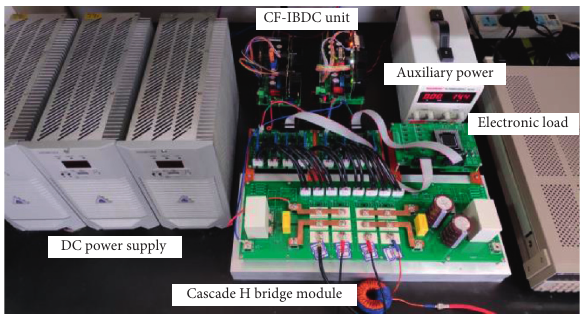
Figure 13: Experimental platform.